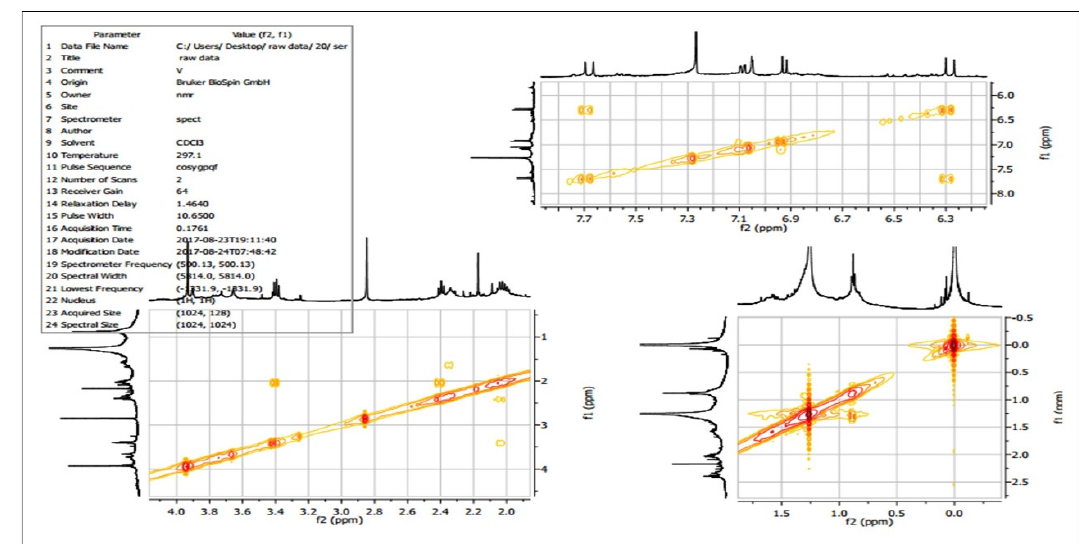
Figure 10. H-1H COSY NMR analysis of the purified compound from the extracts of Leucas indica flowers.